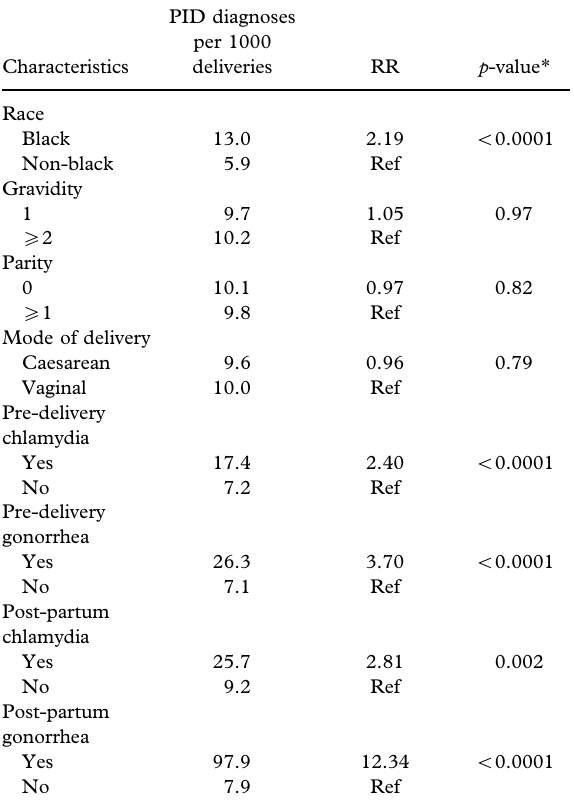
* p -Values were obtained using generalized estimating equations to adjust for correlated observations due to multiple deliveries in some women. RR, risk ratio; Ref, reference.